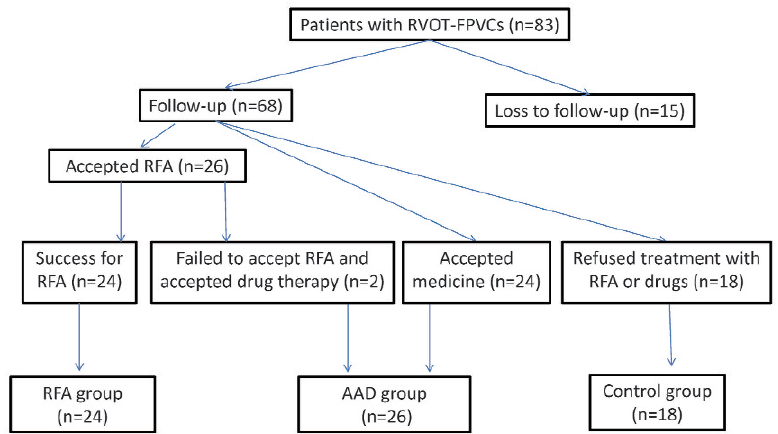
Figure 1 - Patient enrollment